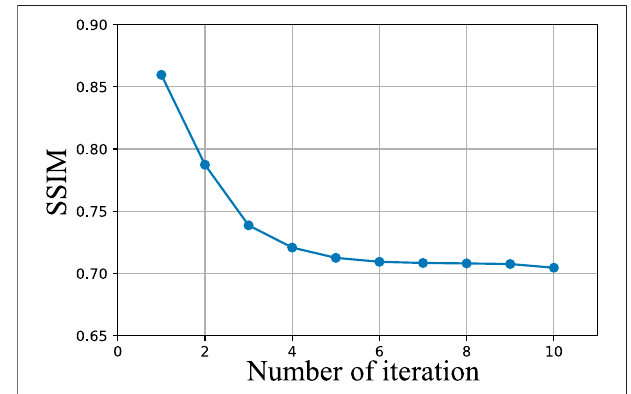
FIGURE 8 | Transition of SSIM.